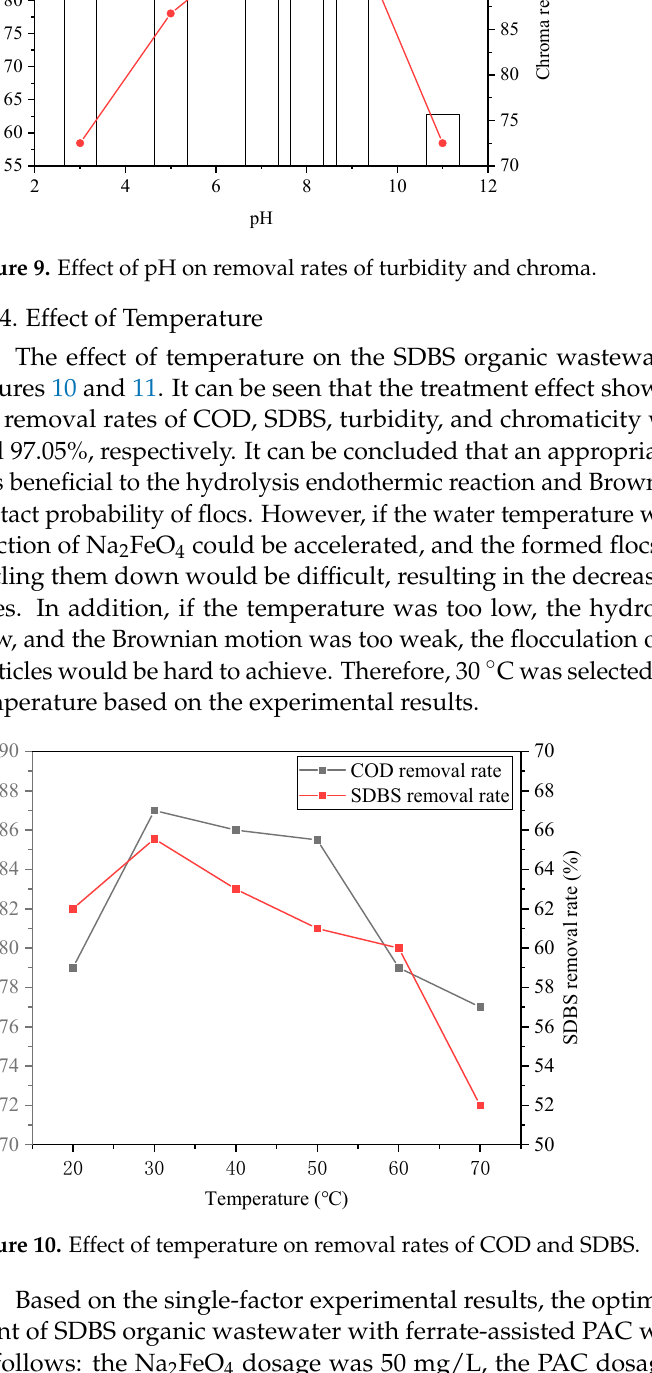
Figure 8. Effect of pH on removal rates of COD and SDBS.